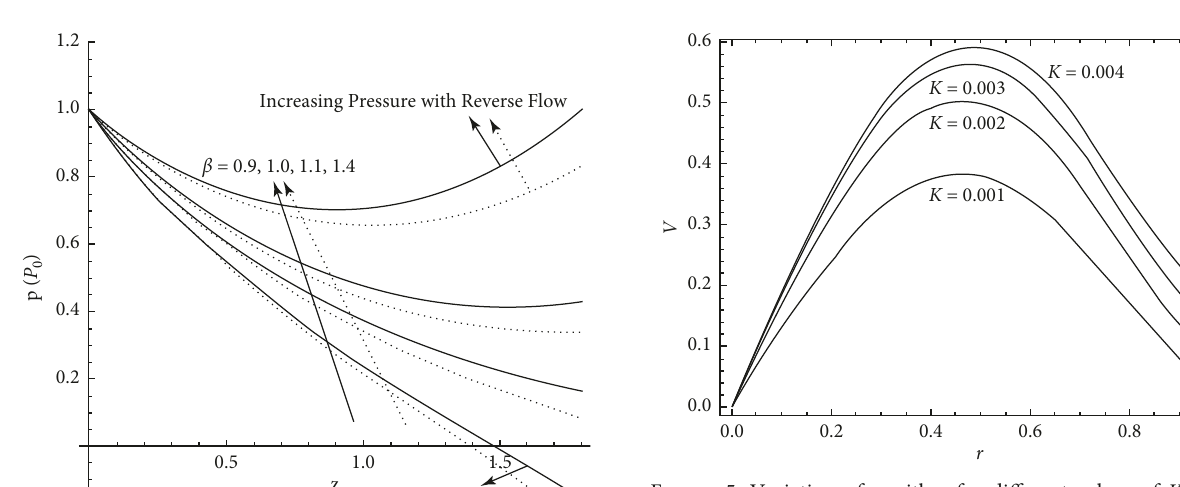
Figure 5: Variation of v with r for different values of K , where Figure 2: Variation of pressure p / P 0 with z for different values of β .